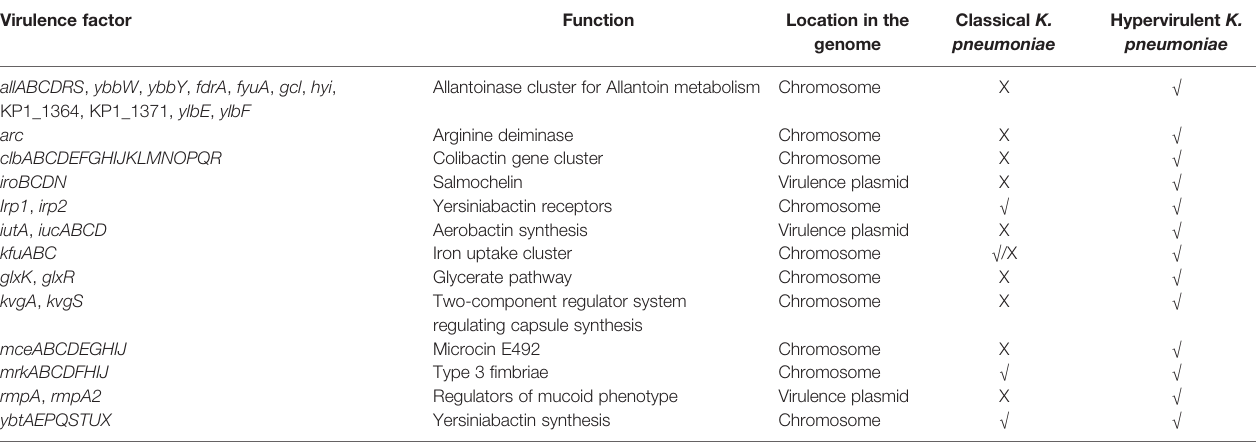
TABLE 3 | Virulence factors among classical and hypervirulent Klebsiella pneumoniae and their